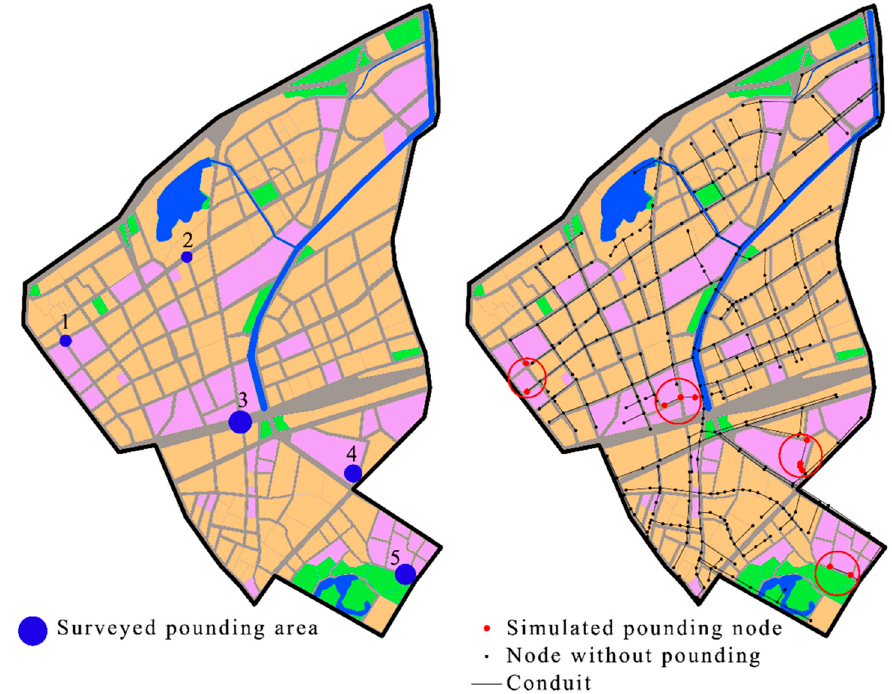
Figure 4. Locations of surveyed pounding areas and simulated flooding nodes.